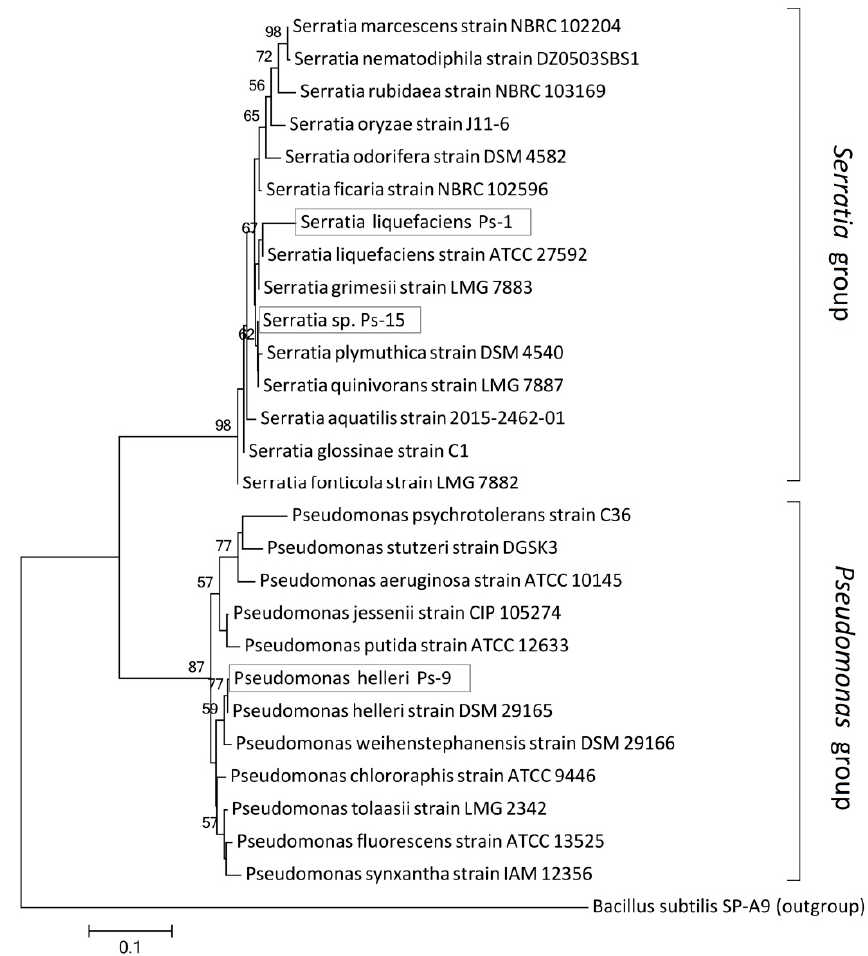
Figure 1. A Neighbor-Joining phylogenetic tree based on 16S rRNA partial sequences demonstrated for the analyzed strains of plant growth-promoting bacteria (PGPB) compared to other strains; the bar indicates sequence divergence.